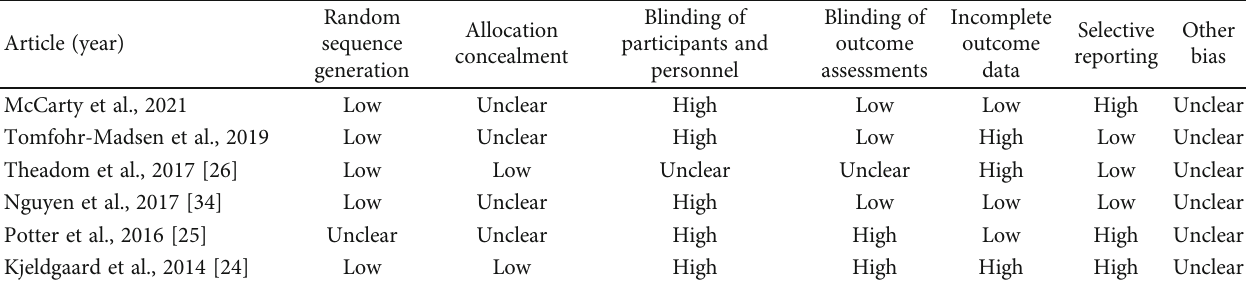
Table 3: The Cochrane Collaboration ’ s tool for assessing risk of bias for methodological assessment.